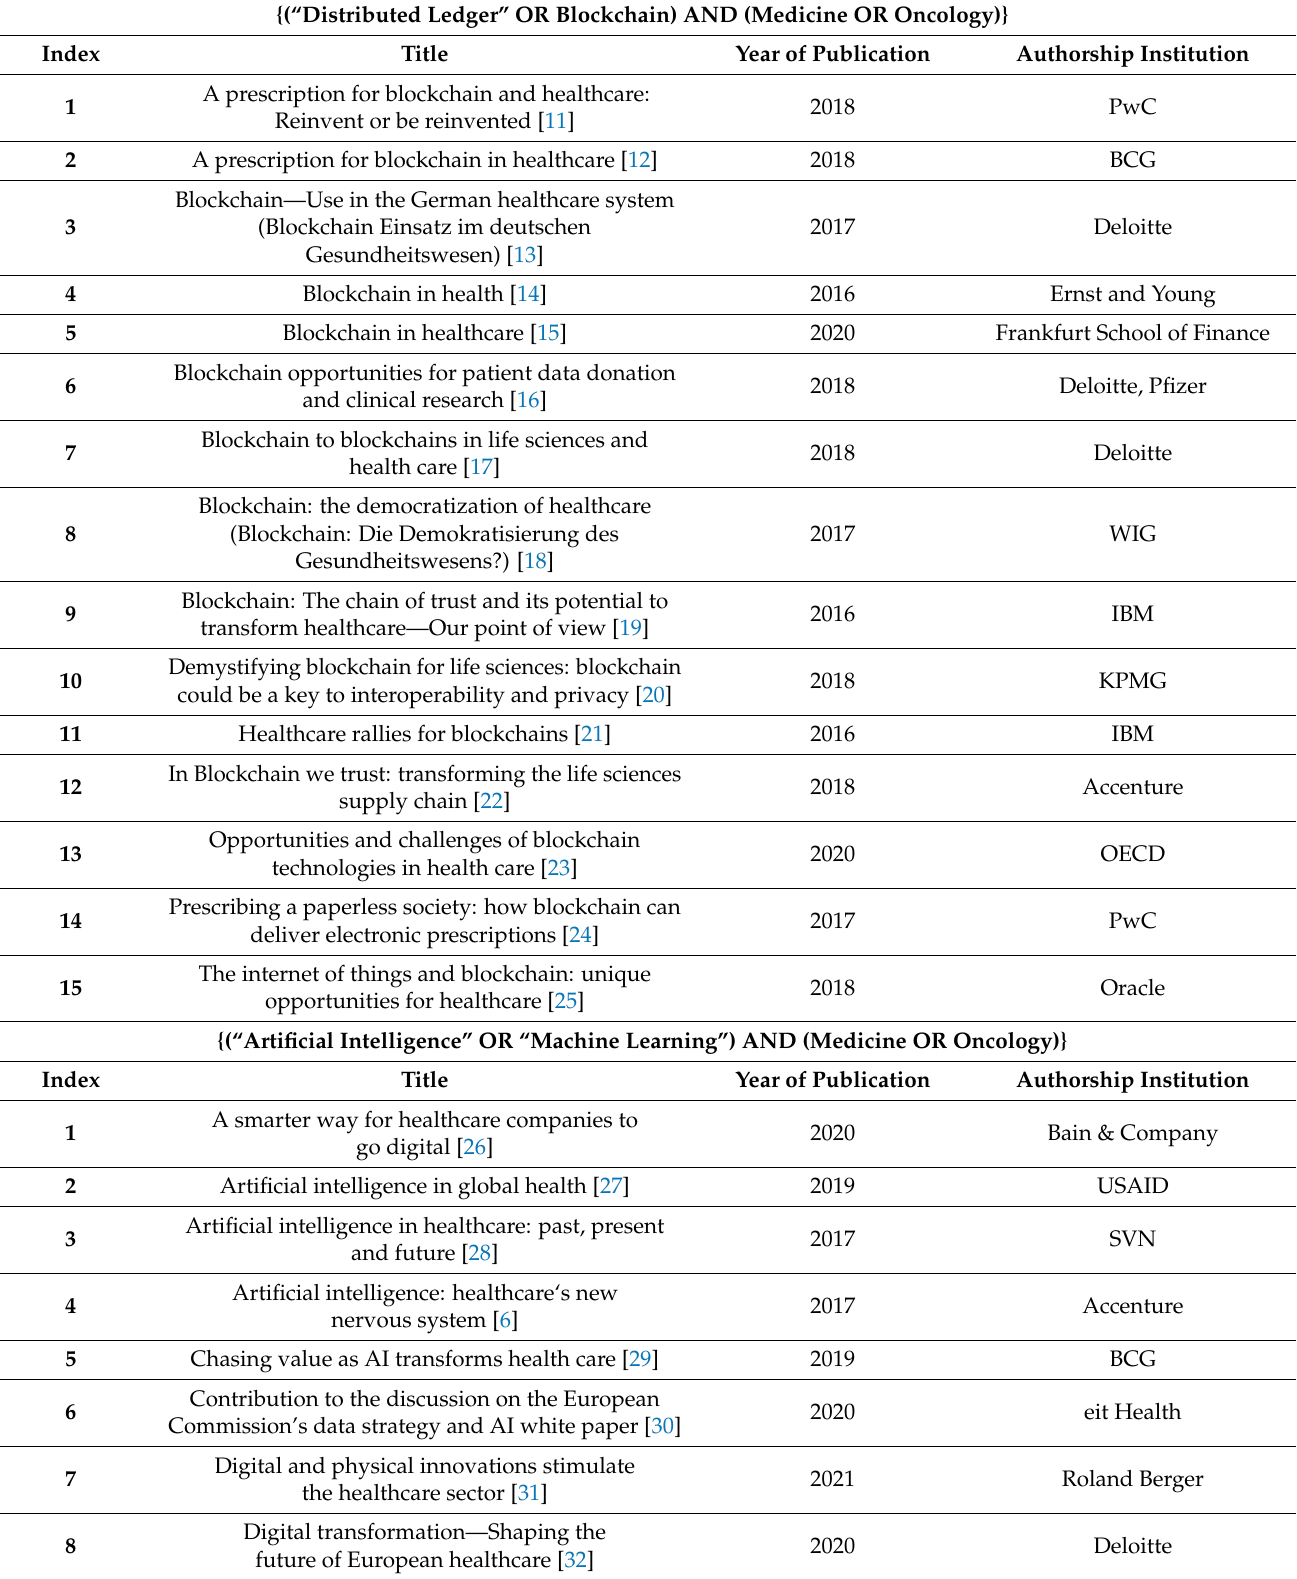
Table 3. Results of the Boolean combination